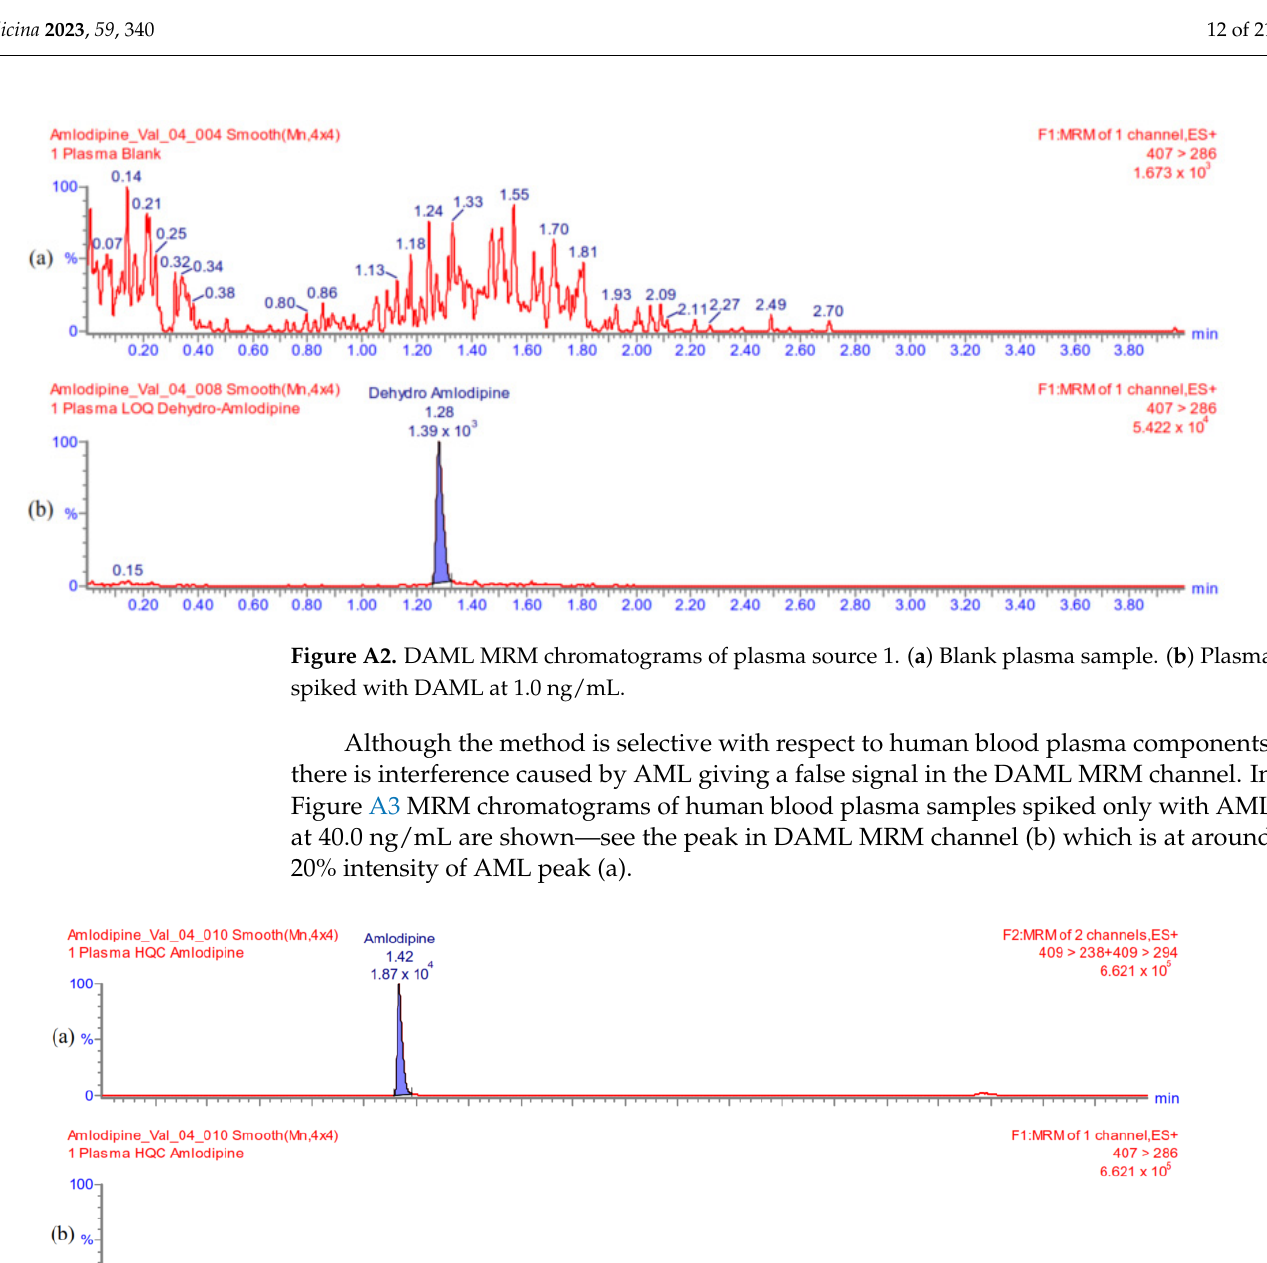
Figure A4. MRM chromatograms of human blood plasma sample spiked with AML and DAML. ( a ) AML (1.42 min) and ( b ) DAML (1.29 min) both at 40 ng/mL. Appendix A.5.2. Carry-Over Carry-over was tested using injecting the blank human blood plasma sample (see Figure A5) following the injections of the highest plasma calibration standard of 50.0 ng/mL (see Figure A6). No carry-over was observed for AML and DAML. Figure A5. Chromatograms of highest plasma calibration standard 50.0 ng/mL. ( a ) AML and ( b ) DAML.